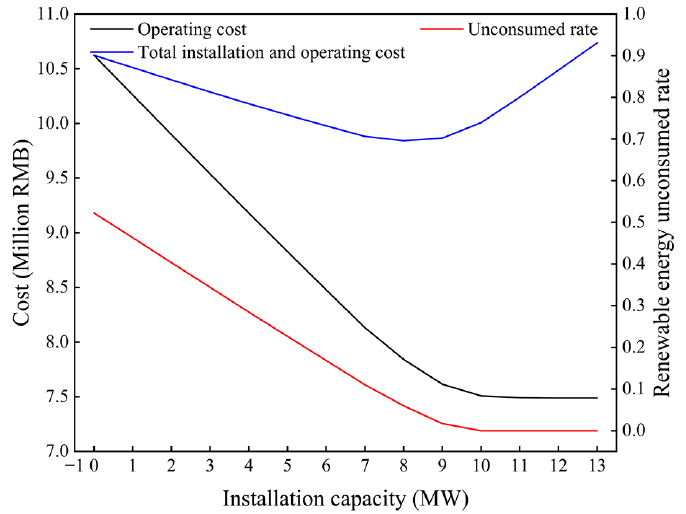
Figure 9. Cost and consumption of PIES 1 with different installed P2G capacities in Scenario 2.